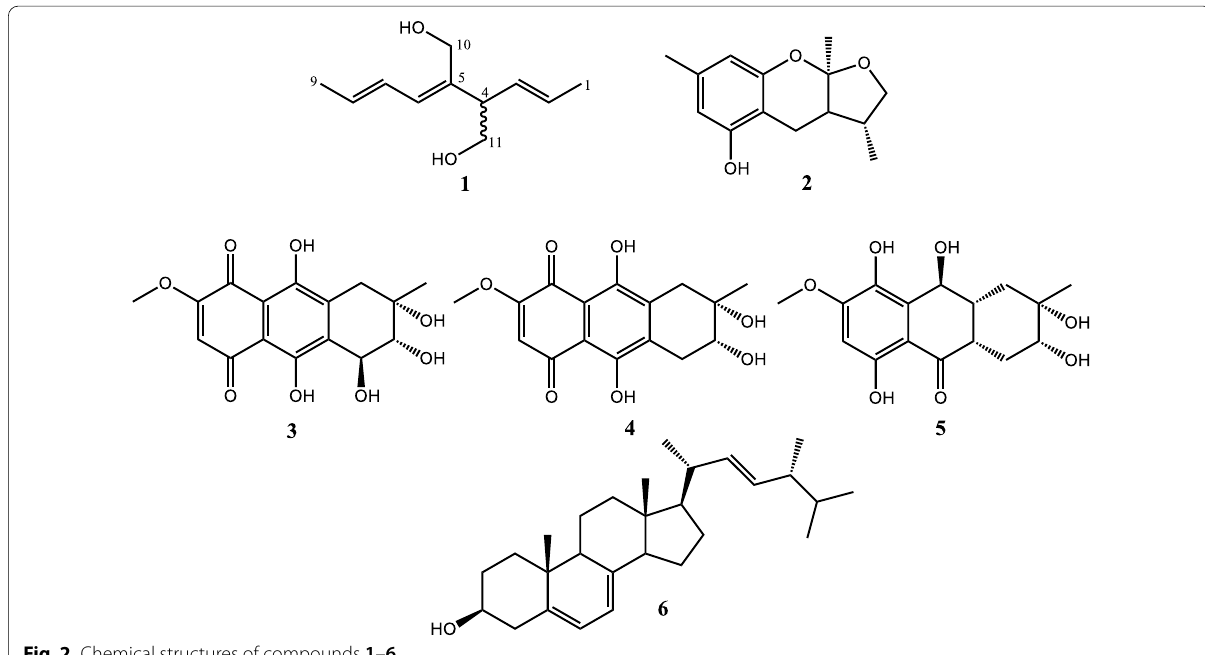
Table 1 IC and cell viabillity values of compounds in BV‑2 50 microgial cells